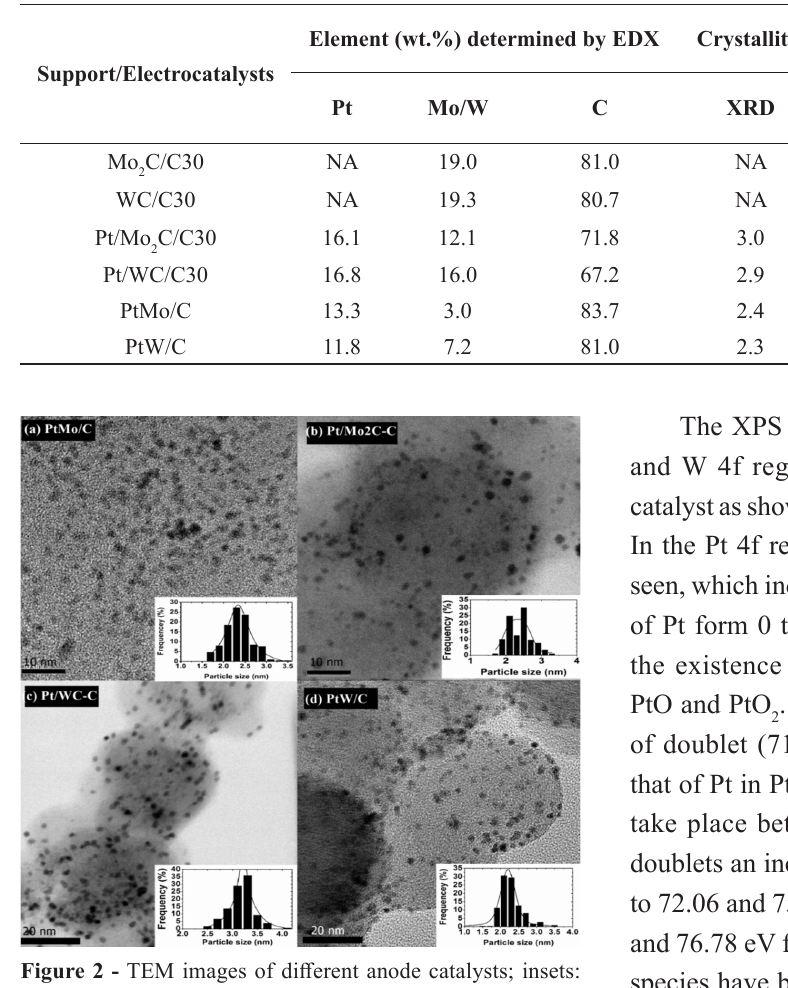
Elemental compositions, crystallite/diameter sizes and lattice parameters of various electrocatalysts.